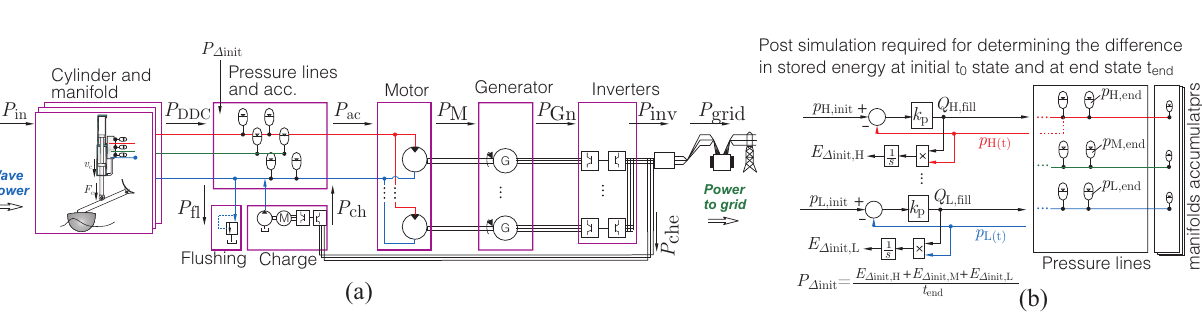
Figure 28. ( a ) the definition of average power input and output of the different subsystems; and ( b ) how the difference in stored energy is calculated.